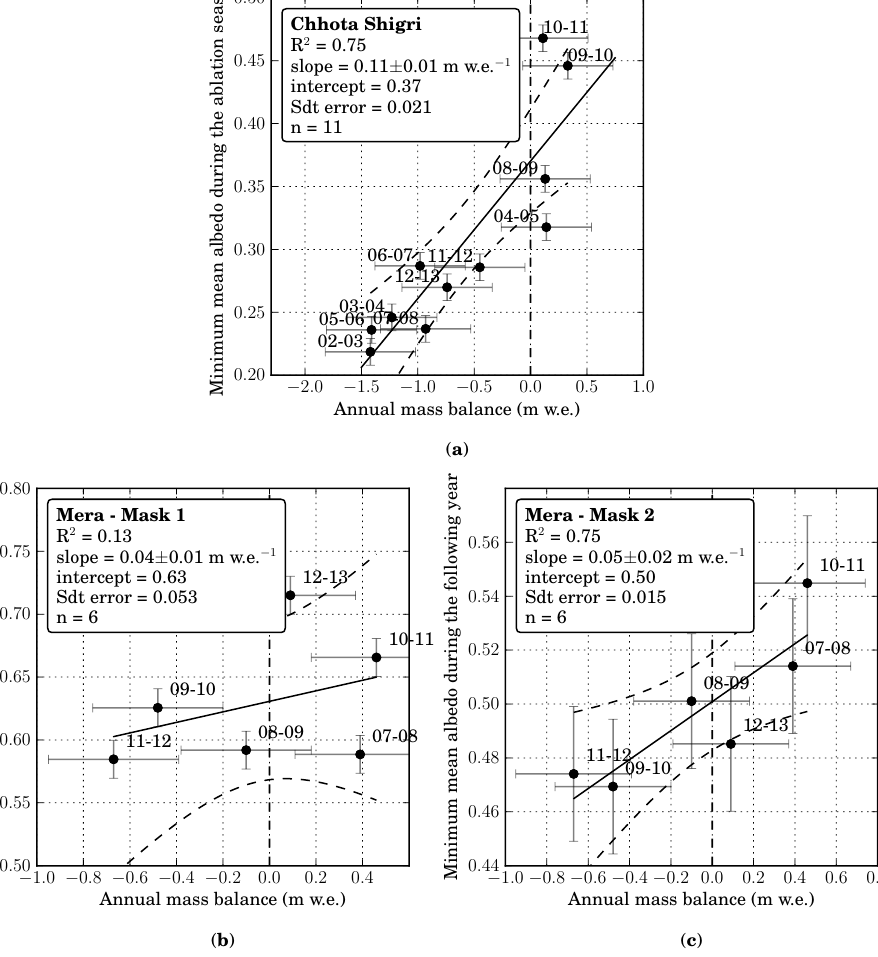
Figure 9. AMAAG as a function of B a for Chhota Shigri Glacier (a) and Mera Glacier with mask 1 (b) and mask 2 (c) . The error bars for the mass balance are ± 0.40m.w.e. and ± 0.28m.w.e. for Chhota Shigri and Mera glaciers, respectively. The uncertainty on the mean albedo is calculated as the accuracy of the MODImLab albedo established on Mera Glacier (RMSE = 0.10) divided by the root mean square of the number of pixels in the average ( n = 89, n = 44 and n = 16 for Chhota Shigri and Mera glaciers masks 1 and 2, respectively). At Mera Glacier, the 2012–2013 mass balance has been calculated excluding the heavy snow fall that occurred 13–15 October 2013 to be consistent with the end of the hydrological year ending with the ablation season. It is noteworthy that this mass balance also has a larger uncertainty (not shown on the figure) because of ablation measurements were partly compromised by stakes buried in the snow. Note that the scales are different on the two